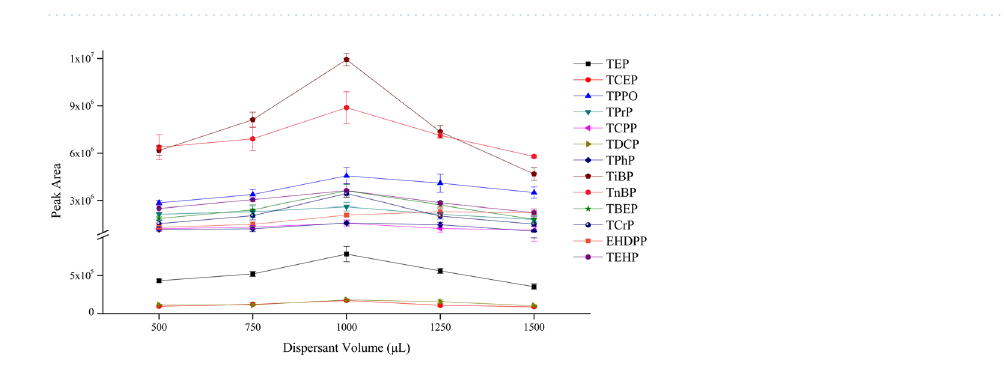
Figure 3. The efficiency of different dispersive solvents on the extraction of OPEs from aqueous samples (n = 3).